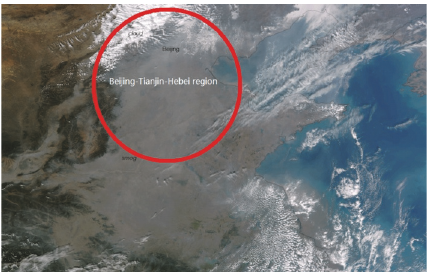
Figure 2: Smog maps of the BTH region in 2014 (sources: NASA).